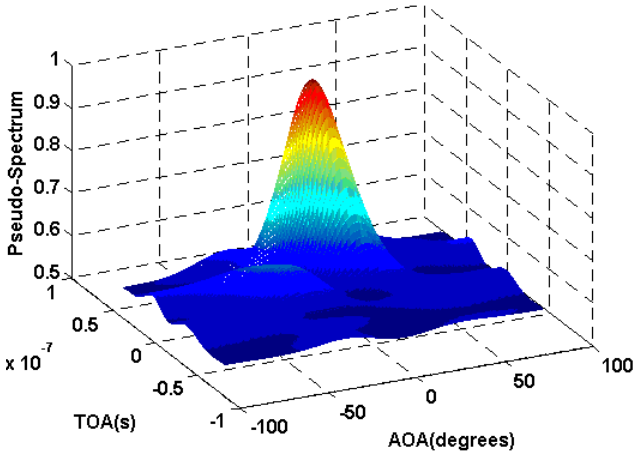
Figure 6. Result of AOA and TOA estimation for the coherent signals without the 2D-SS.